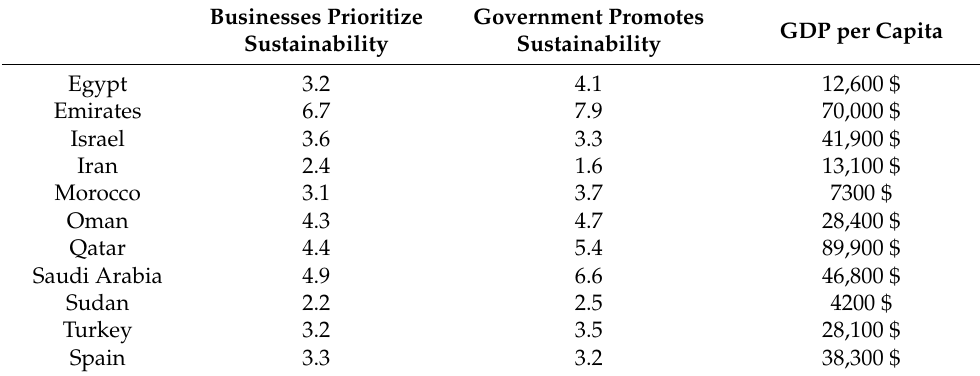
Table 7. National eco-systems for sustainability in MENA and Spain.